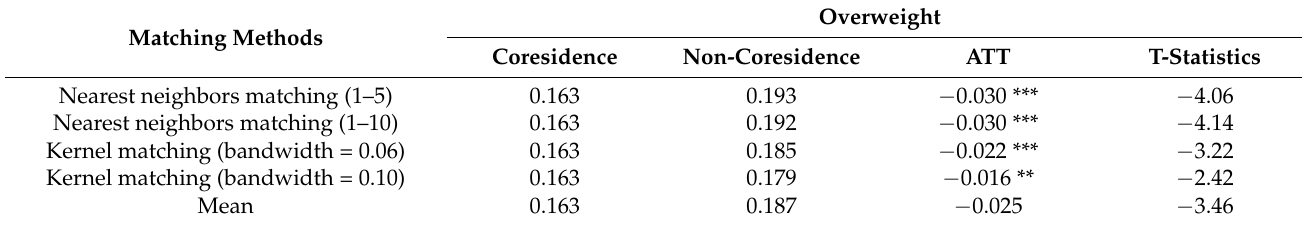
Table 4. Effect of grandparents’ coresidence on children and adolescents whether overweight.